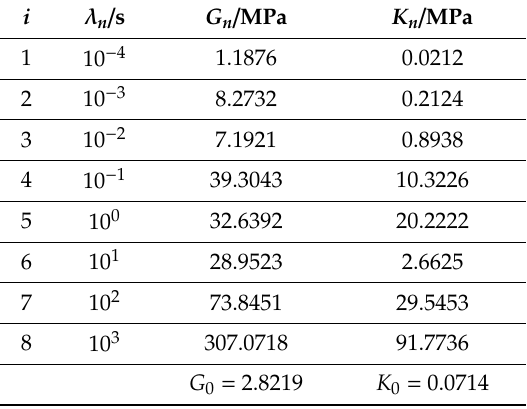
Table 2. Prony series coe ffi cients of the relaxation modulus for asphalt mortar.